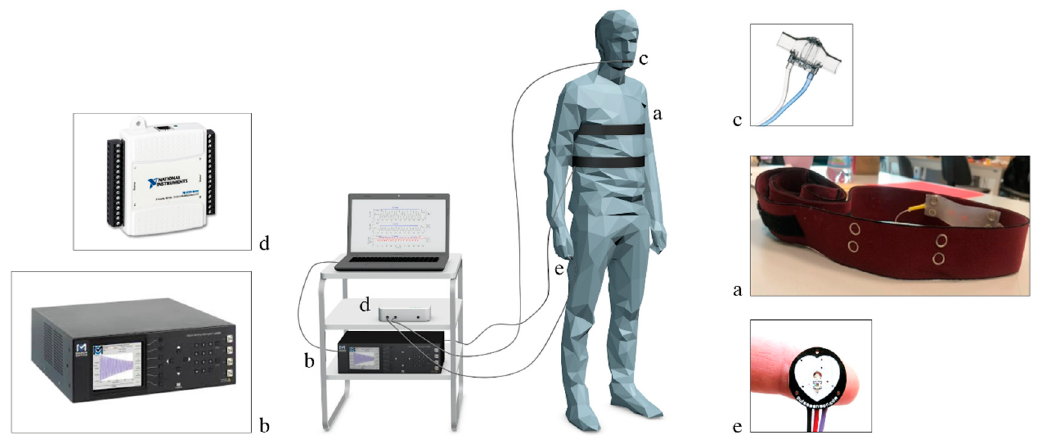
Figure 2. Experimental set-up: ( a ) smart textile consisting of two elastic bands instrumented by flexible FBGs, ( b ) FBG interrogator, ( c ) flow sensor, ( d ) DAQ, and ( e ) PPG sensor.